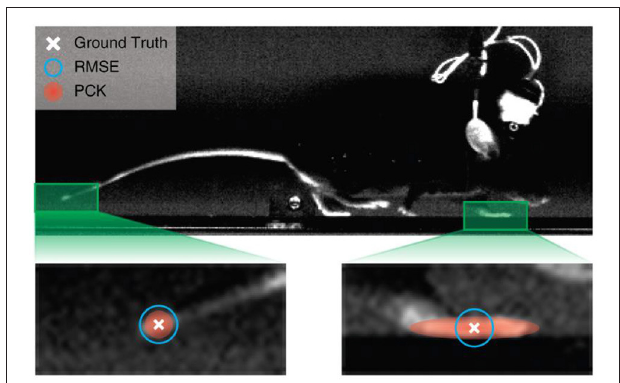
FIGURE 2 | Comparison of evaluation methods. The ground truth is defined through human labelling. Points with a given RMSE forms a circle around the ground truth. The heatmap label, used by the adjusted percentage of correct key points (aPCK), can be defined by the human labeller to cover the entire ROI, whereas the RMSE circle can be too large and include points that fall outside the target region (in this case the paw) or too small and thereby miss valid points of the labelled object.